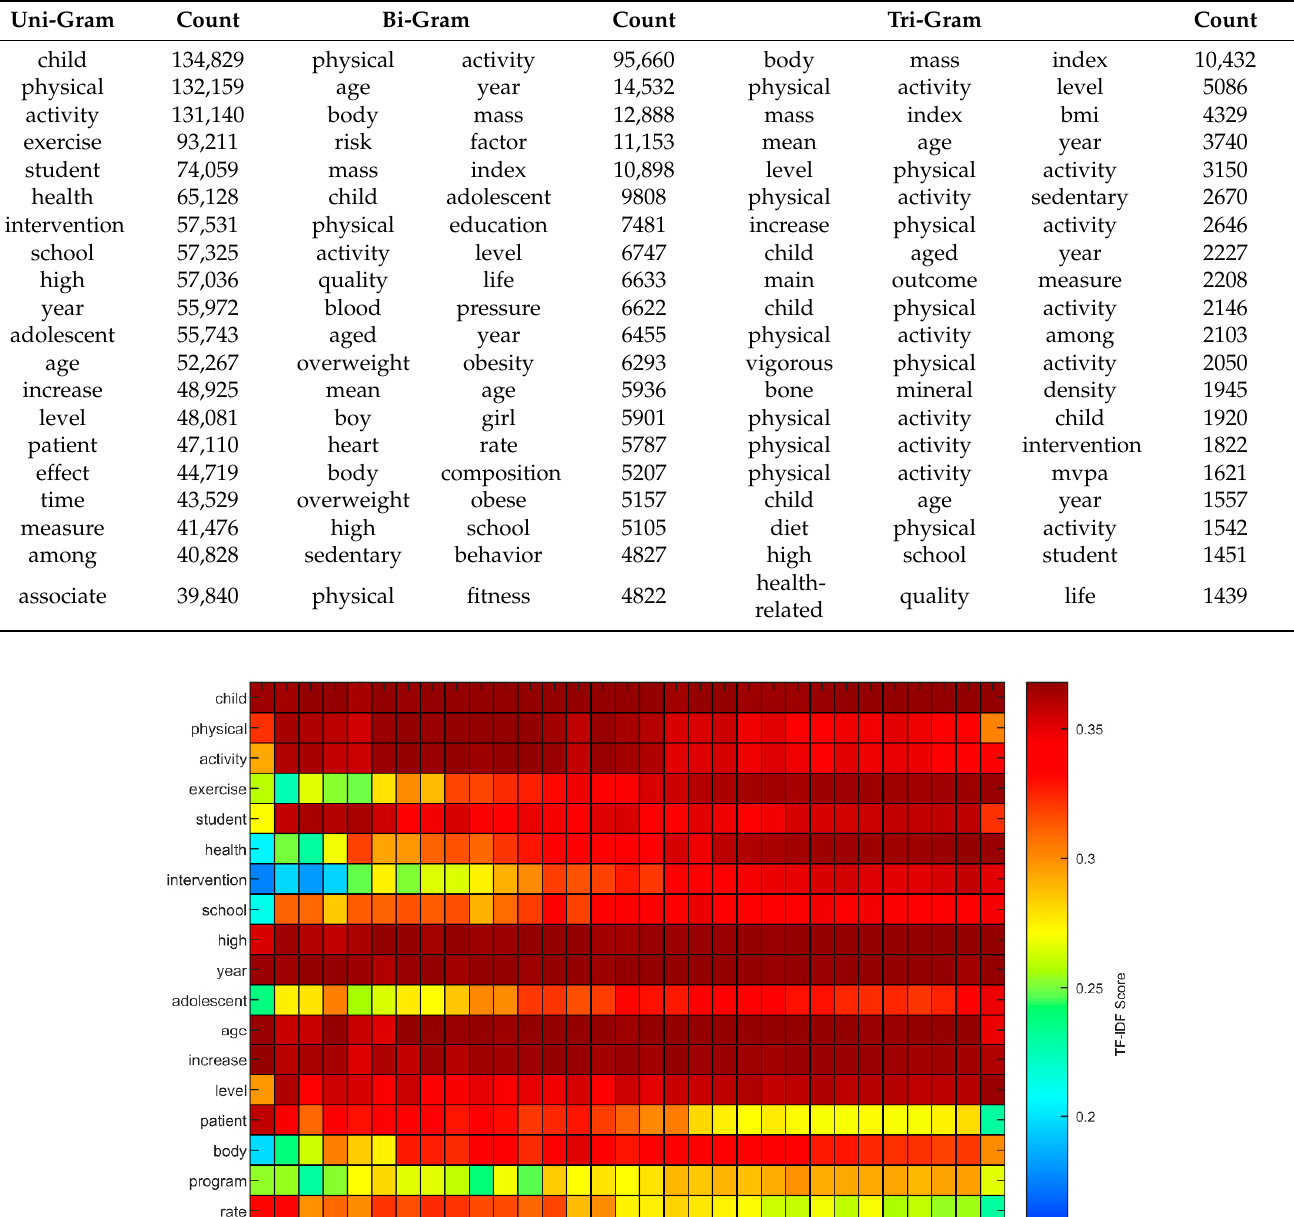
Table 1. Top 20 N-grams found in published papers.